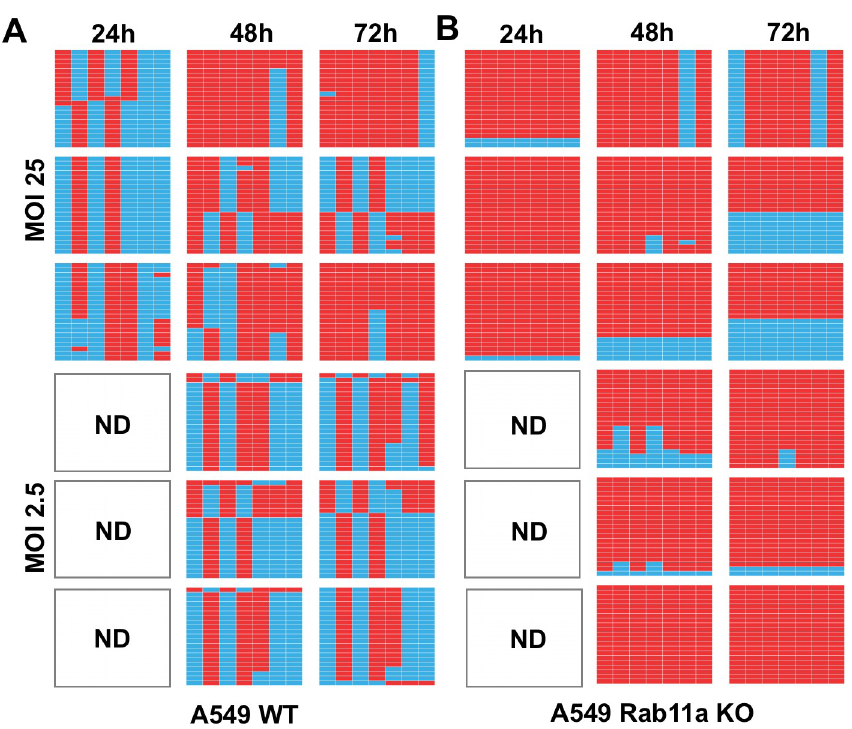
Fig 7. TNTs serve as conduits for genome mixing and reassortment in a Rab11a dependent manner. Genotypes of clonal viral isolates collected from the culture medium of NL09 Δ HA Venus WT and NL09 Δ HA Scarlet VAR virus infected A549 WTcells [A]or A549 Rab11a KOcells [B] co-cultured with MDCK WSN HA cells. Three technicalreplicate co-cultures per condition were sampled serially at the time points indicated and 21 plaque isolates were analyzed per sample. The origin of the gene segments, represented by the columns in each table, is denoted by the colored boxes [blue = WT and red = VAR]. The segments are in order PB2, PB1, PA, NP, NA, M and NS moving from left to right. The white panels indicate samples where no plaques were detected [ND = not detected].